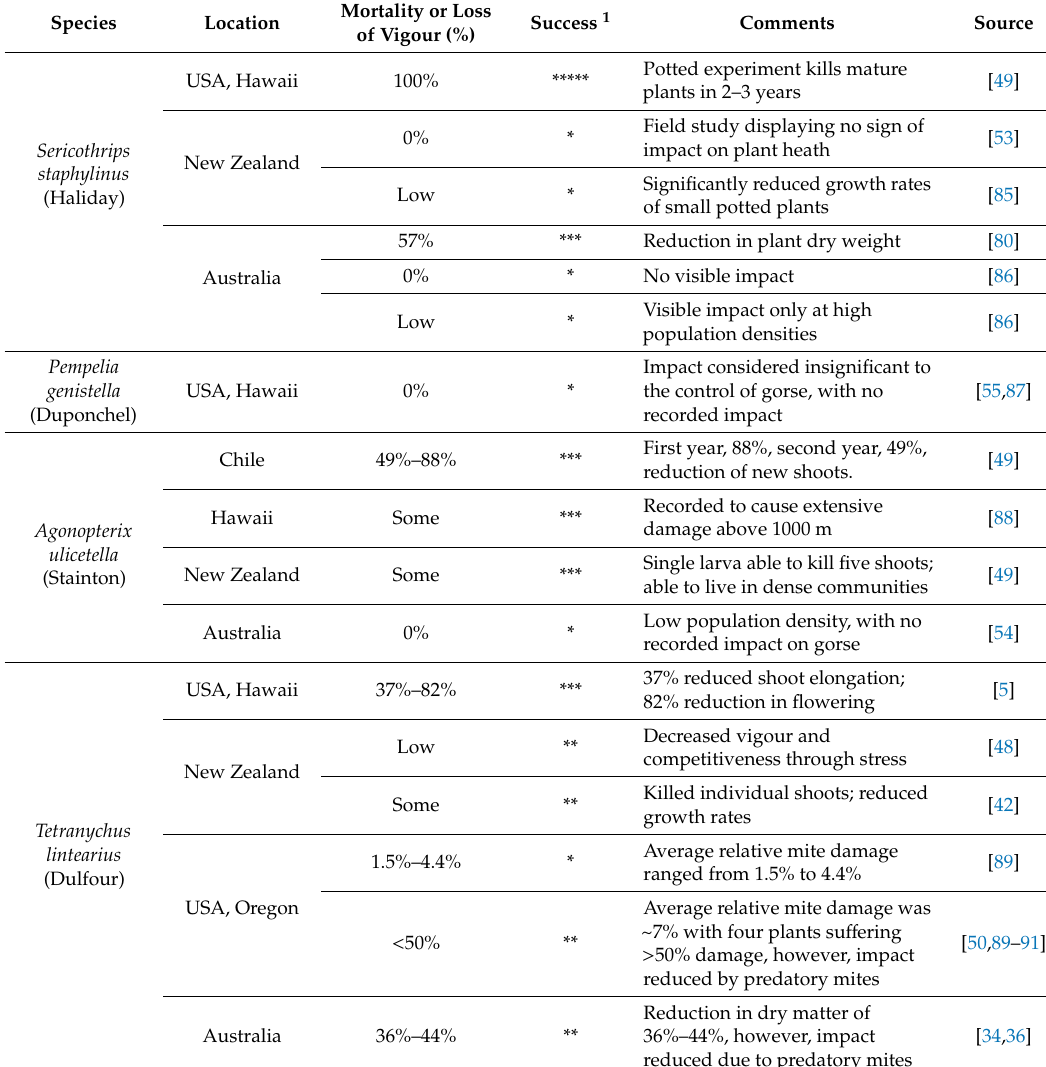
Table A1. Biological controls (phytophagous insects) and their success in reducing plant vigour and population size of common